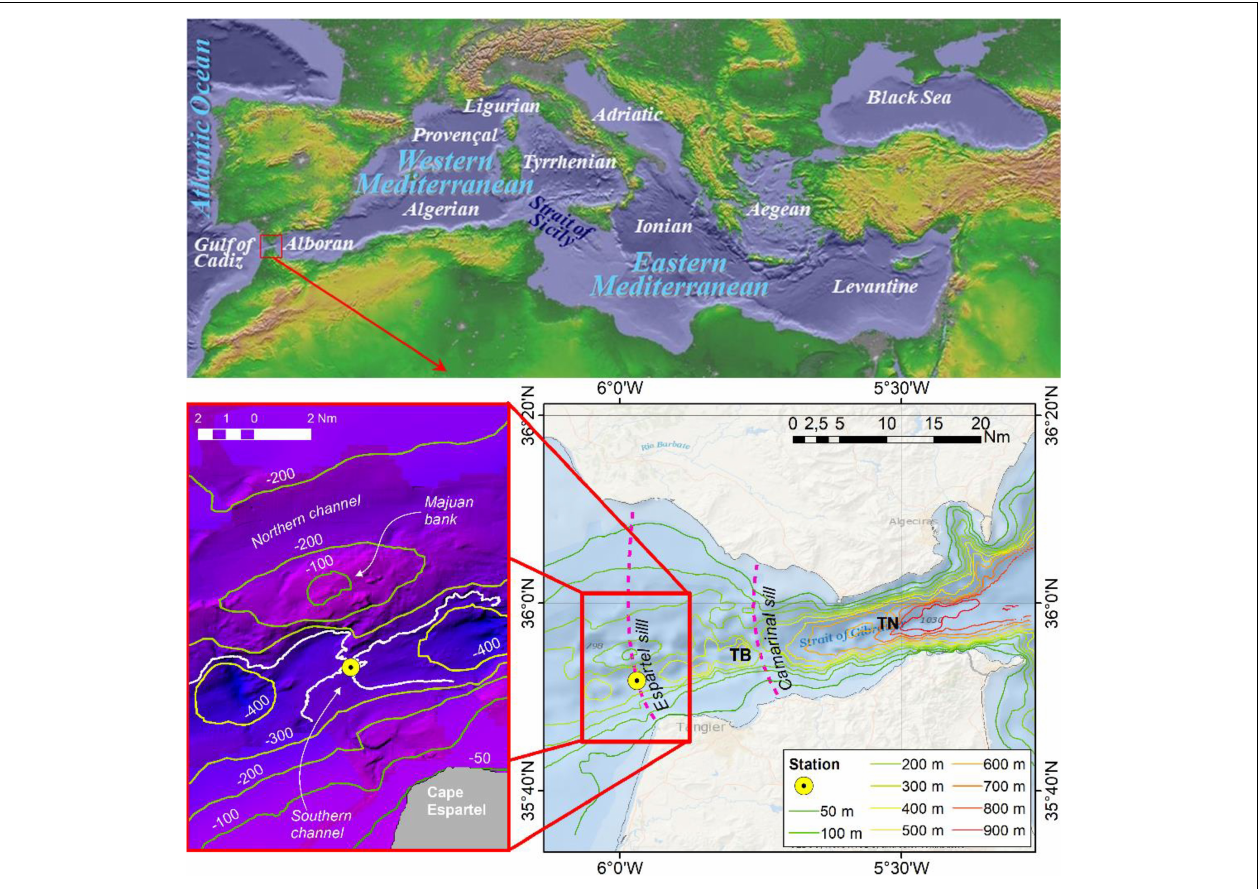
FIGURE 1 | Top panel. Map of the Mediterranean Sea with the name of the main basins and sub-basins. Red rectangle indicates the area of the Strait of Gibraltar enlarged below. Bottom-right panel: map of the Strait with indication of relevant topographic features. TN stands for Tarifa Narrows; TB, for Tangier Basin. Red rectangle indicates the zone of Espartel sill enlarged in the bottom-left panel. Yellow dot indicates the location of the monitoring station. Most of the Mediterranean outflow goes along the channel between Majuan bank and the African shore (Sánchez-Román et al., 2009; Sammartino et al.,